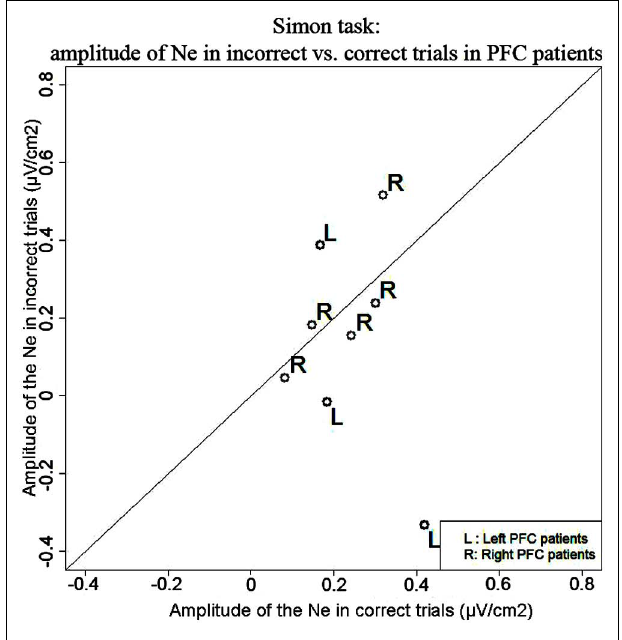
FIGURE 6 | Comparison of the amplitude of the Ne in correct ( x axis) vs. error ( y axis) trials in the Simon task. Each point represents a patient, points for left PFC patients are black and indicated by the letter “L” and points for right PFC patients are gray and are indicated by the letter